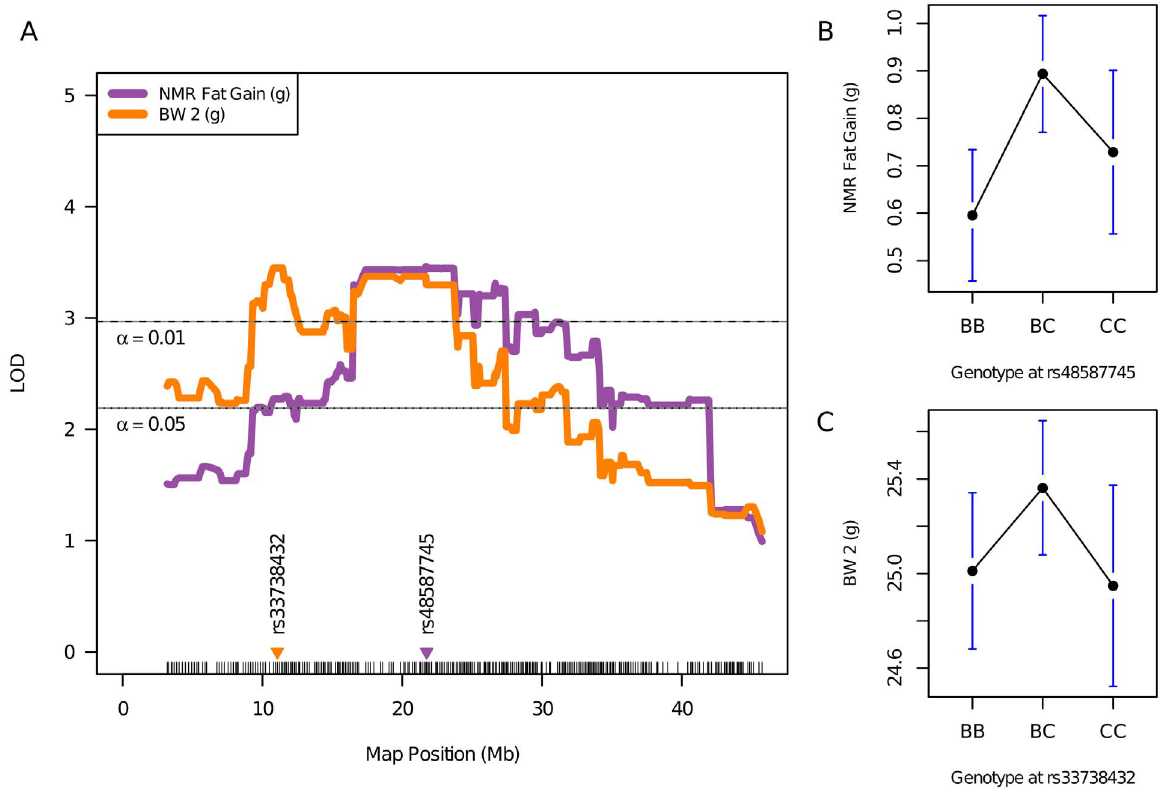
Figure 5. Short-term body fat and weight gain is controlled by a proximal chromosome 17 locus. Legend: Interval map of proximal chromosome 17 illustrates fine-mapped QTL for body fat gain and body weight gain after 10 d of macronutrient diet selection, in B6.CAST-17.1 subcongenic-derived F 2 mice (left), and includes uncorrected phenotypic means for the peak marker of each QTL (right). The significant LOD threshold values for a =0.01 and a =0.05 were 2.97 and 2.19, respectively, as determined by 1,000 permutation tests. The locations of markers nearest the peak LOD scores are shown on the x-axis, e.g., rs48587745 .